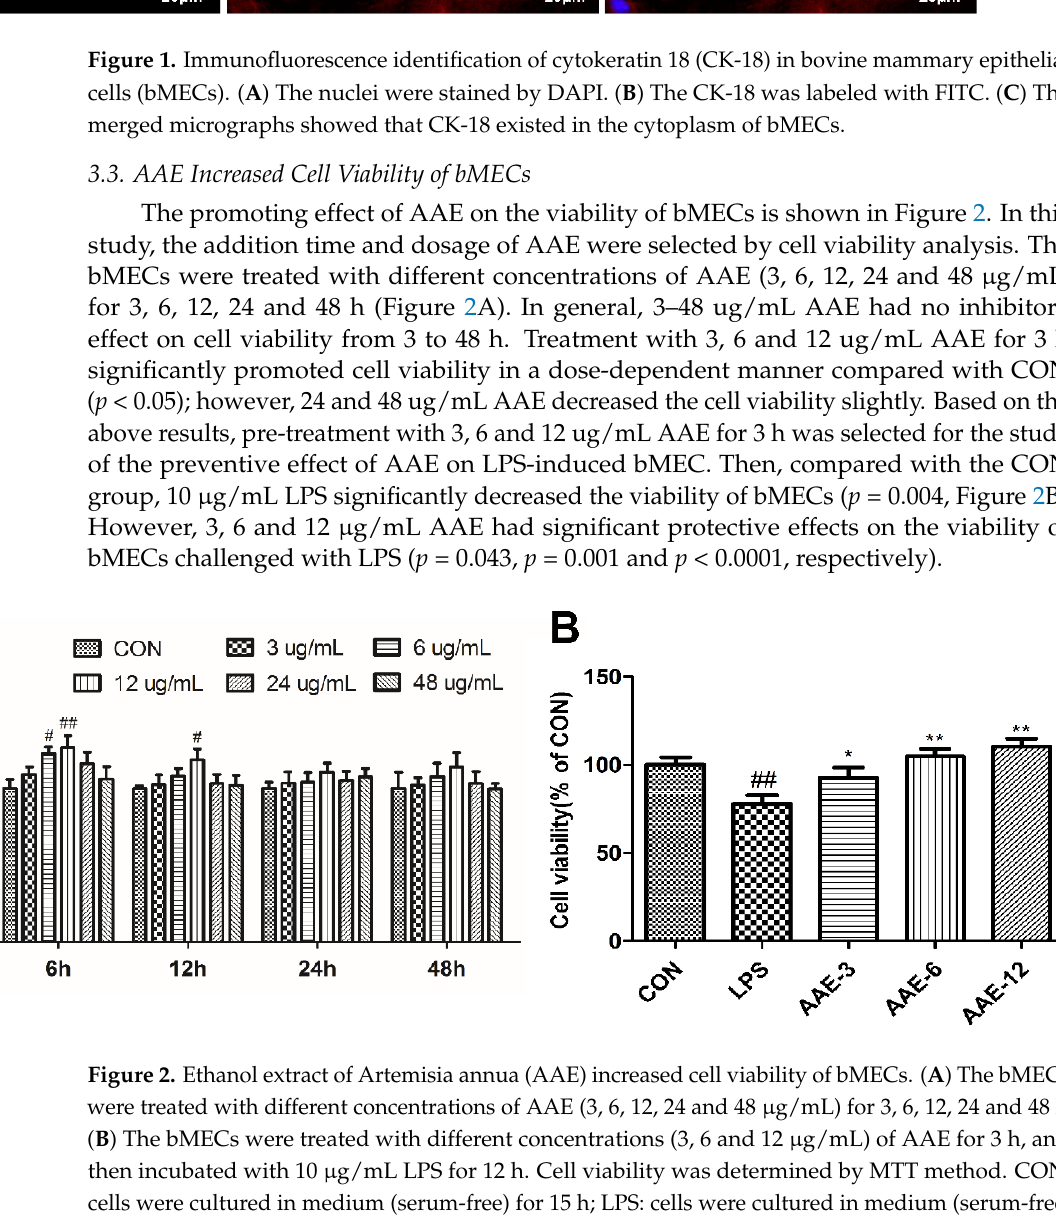
Figure 1. Immunofluorescence identification of cytokeratin 18 (CK-18) in bovine mammary epithelial cells (bMECs). ( A ) The nuclei were stained by DAPI. ( B ) The CK-18 was labeled with FITC. ( C ) The merged micrographs showed that CK-18 existed in the cytoplasm of bMECs.